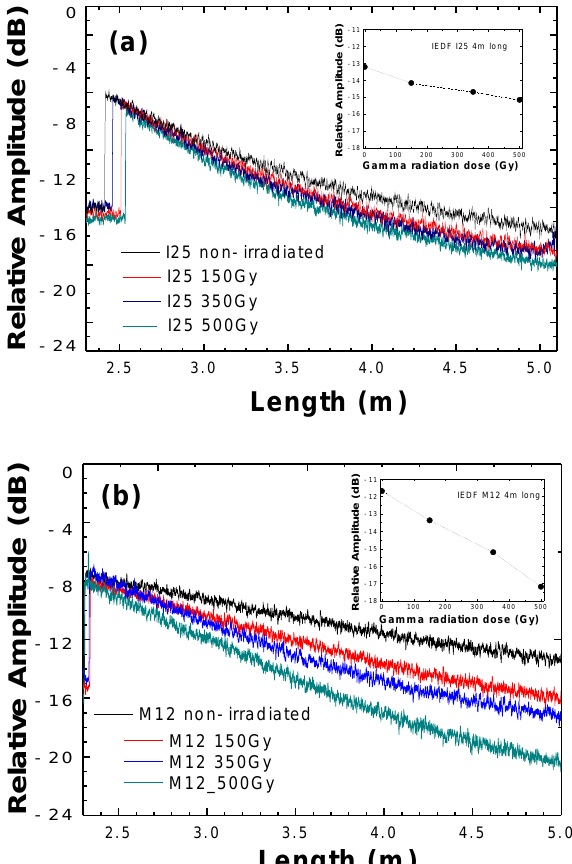
Figure 2. Backscattered optical power of the IEDF type ( a ) I25 and ( b ) M12 as a function of their length for gamma radiation doses of non-irradiated (black), 150 Gy (red), 350 Gy (blue), and 500 Gy (green). Insets: backscattered optical power as a function of gamma radiation doses for a representative length of 4 m long of I25 (inset Figure 2a) and M12 (inset Figure 2b).